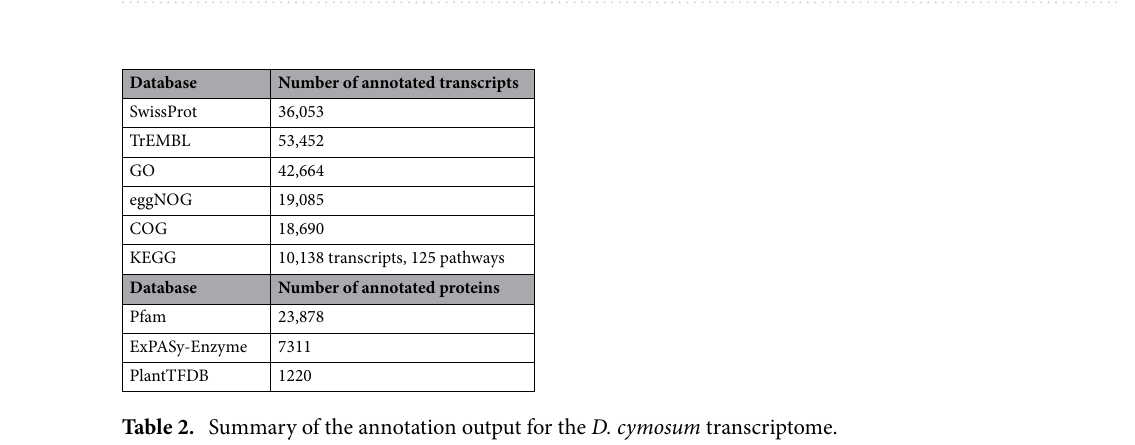
Table 1. Summary of the sequencing, data filtering, assembly and transcriptome completeness output for the D. cymosum transcriptome.